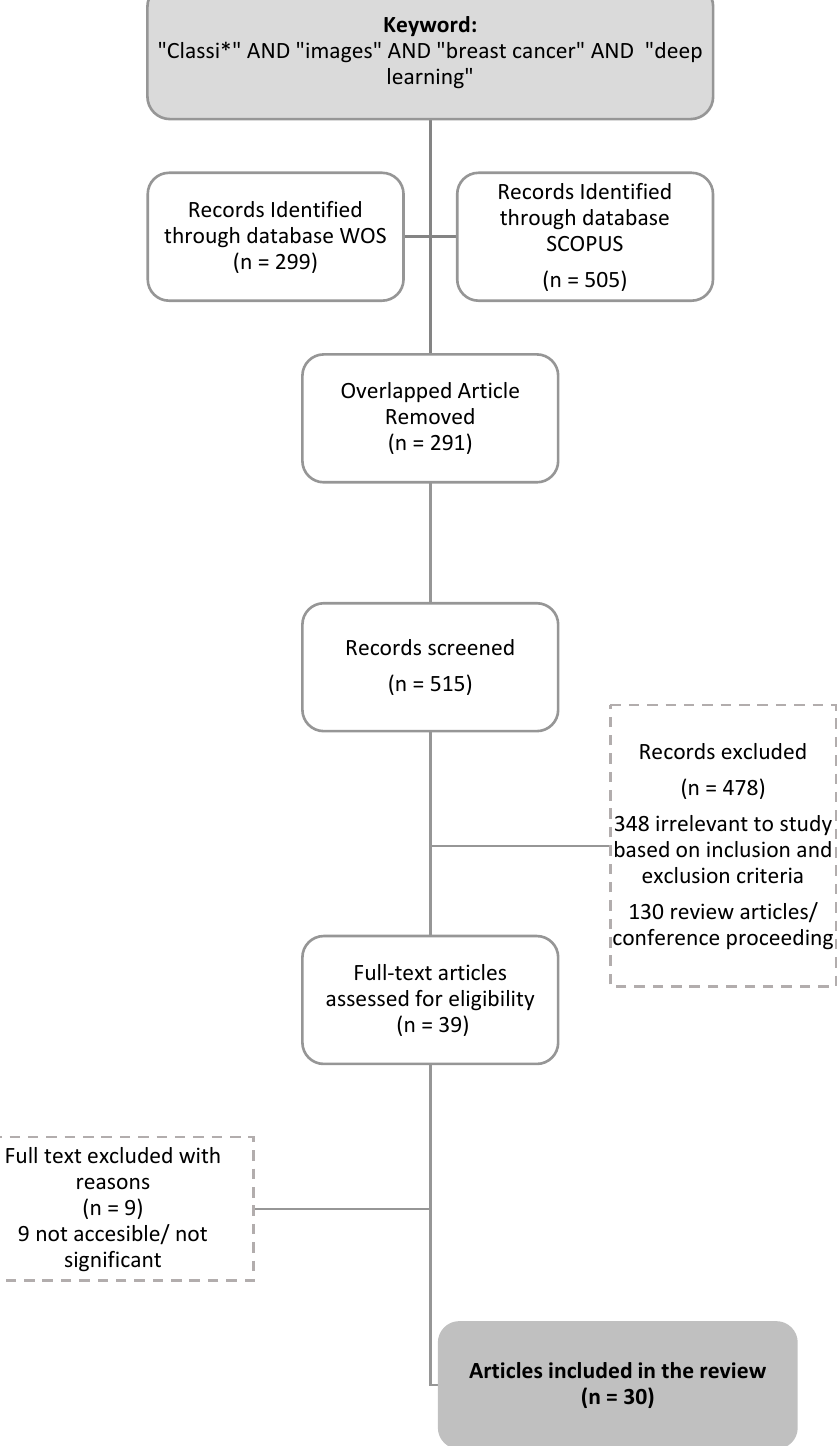
Figure 1. The PRISMA flow diagram of the entire procedure for selecting reviewed